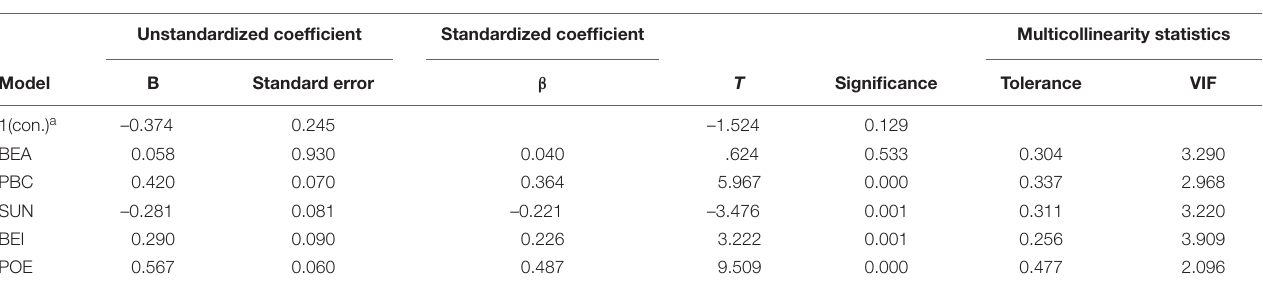
TABLE 4 | Results of multicollinearity analysis.